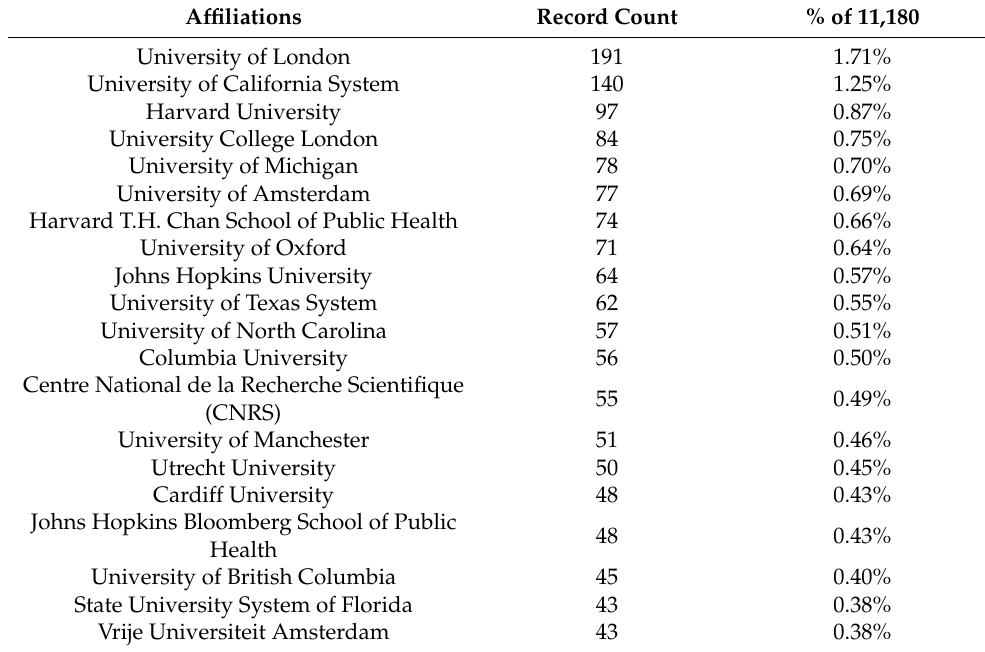
Table 2. Top 20 affiliations for research on “social cohesion”. Multiple affiliations are possible for each